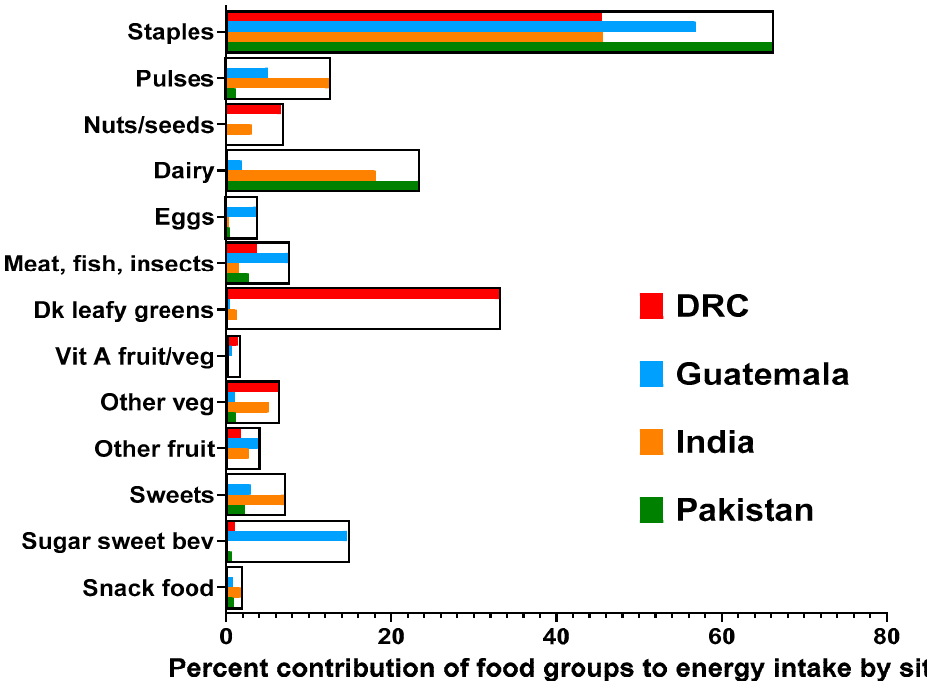
Figure 2. Contribution of food groups to total energy intake of pregnant women in four low- and middle-income countries by site. DRC, Democratic Republic of the Congo.